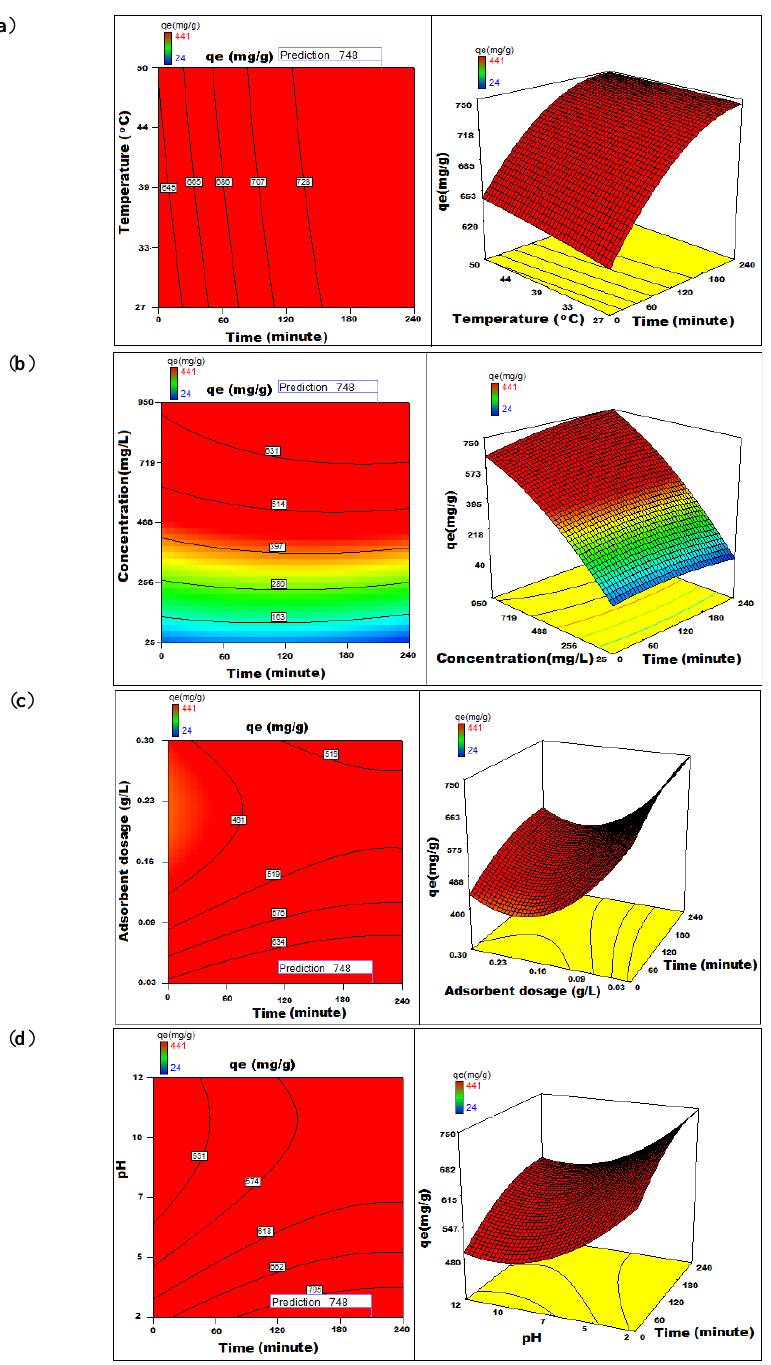
Figure 10. The 2D-contour and 3D-surface plots show the variation of adsorption capacity with ( a ) time versus temperature, ( b ) time versus concentration, ( c ) time versus adsorbent dosage and ( d ) time versus pH.